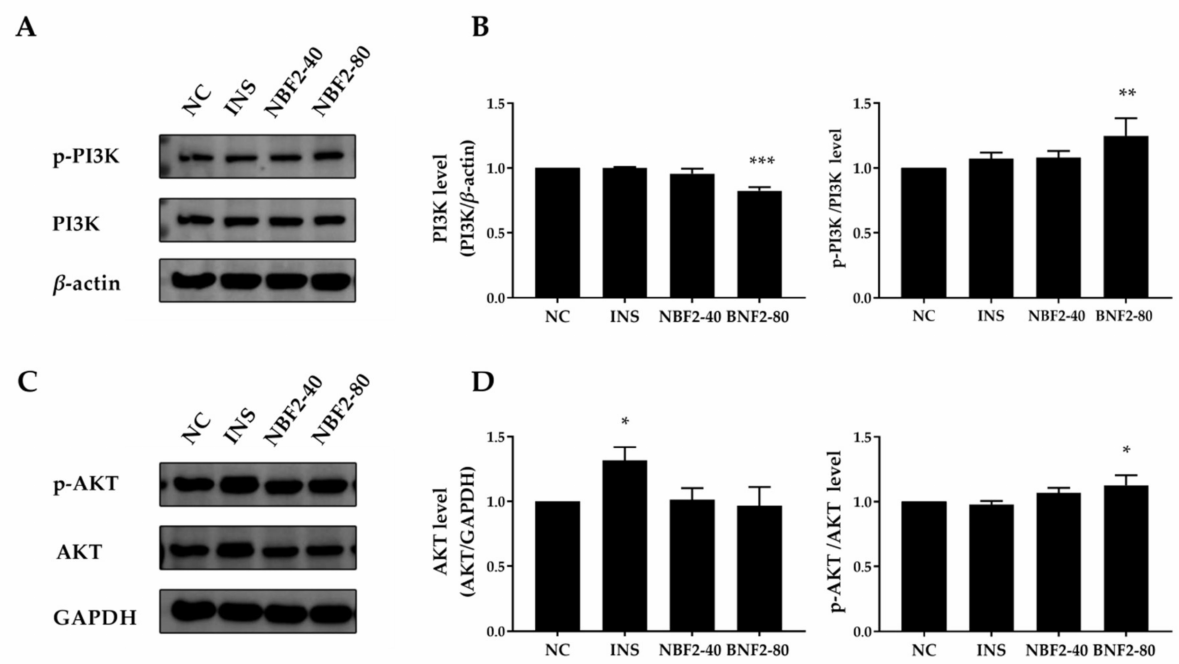
Figure 4. The effects of NBF2 supplementation on p-PI3K (Tyr458), PI3K, p-AKT (Ser473), and AKT protein expression in 3T3-L1 adipocytes. ( A ) p-PI3K (Tyr458) and PI3K protein expression, ( B ) expression levels of PI3K/ β -actin and p-PI3K/PI3K, ( C ) p-AKT (Ser473) and AKT protein expression, and ( D ) expression levels of AKT/GAPDH and p-AKT/AKT. NC: negative